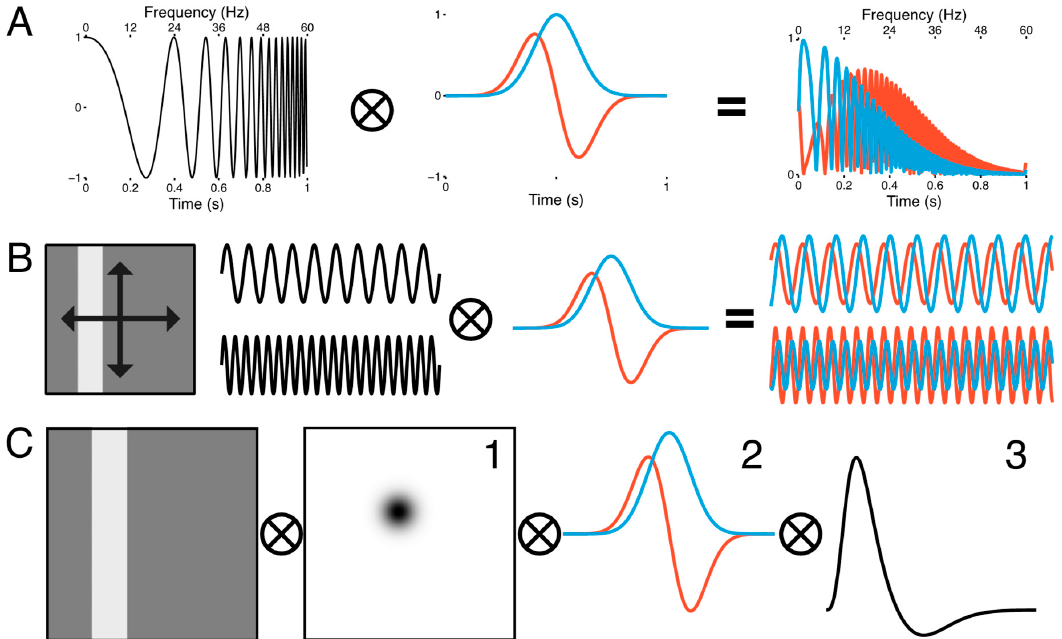
Figure 2. Spatiotemporal population receptive field model. ( A ) The sustained (blue) response is modeled as a Gaussian receptive field in time, while the transient (red) response is modeled as its first derivative (middle panel). When a frequency modulated signal (left panel) is passed through the transient and sustained temporal receptive fields, the amplitude of the output if frequency-dependent (right panel). ( B ) Spatial tuning was encoded with a sweeping, uniform luminance bar stimulus that traversed the visual field twice along four trajectories (left panel). Flicker modulation was embedded in the spatial encoding regime. The luminance of the bar sinusoidally flickered at 10 Hz for the first set of four bar passes and 20 Hz for the second set of four bar passes (middle panels). At 10 Hz, the sustained response had a greater amplitude than the transient response, but at 20 Hz this pattern reversed (right panel). ( C ) The spatial response was extracted by convolving the bar stimulus with a 2D Gaussian (1), which was in turn convolved with the transient and sustained temporal receptive fields (2). This was then convolved with the hemodynamic response function (3) to approximate the BOLD signal.